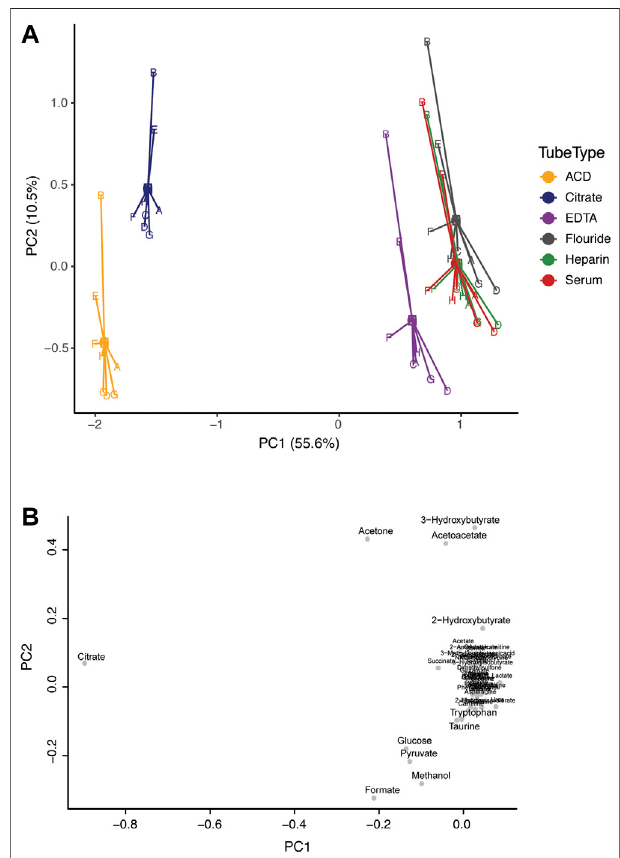
FIGURE 1 | Comparison of the metabolic pro fi le in serum and plasma samples from eight individuals. Subjects are represented by letters (A – H), and color indicates tube-type according to the legend (A) Principal component analysis (PCA) centroid plot of samples and (B) the corresponding loadings